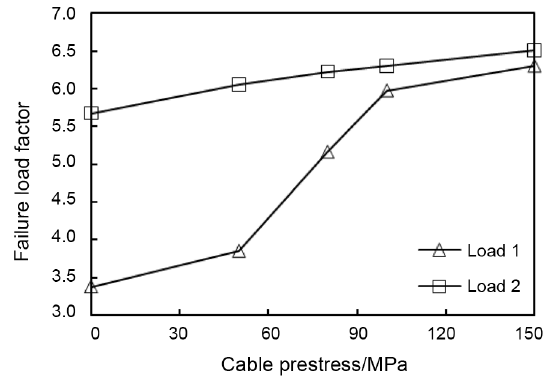
Fig. 16. Failure loads with different cable pre-stress